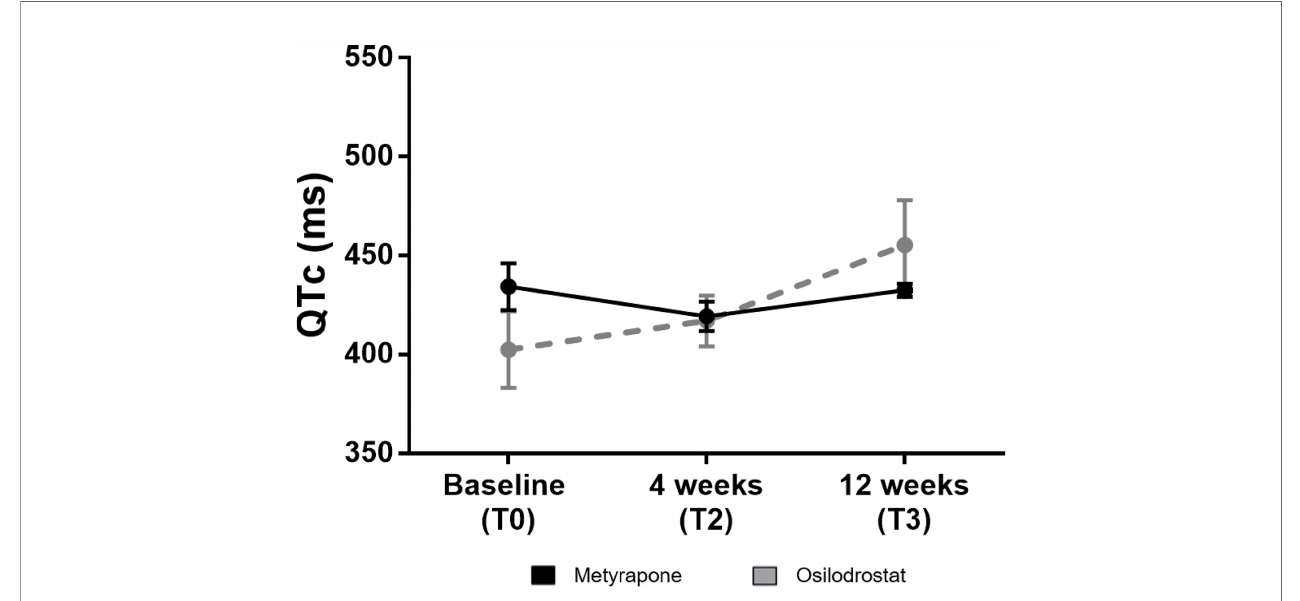
FIGURE 4 | QTc-interval at baseline and during follow-up under metyrapone or osilodrostat treatment. Changes in absolute values of QTc-interval in electrocardiography under metyrapone or osilodrostat treatment. Electrocardiogram and QTc-interval analysis was performed at 4 weeks (T2) and at 12 weeks (T3). Values are reported with mean and standard error of mean